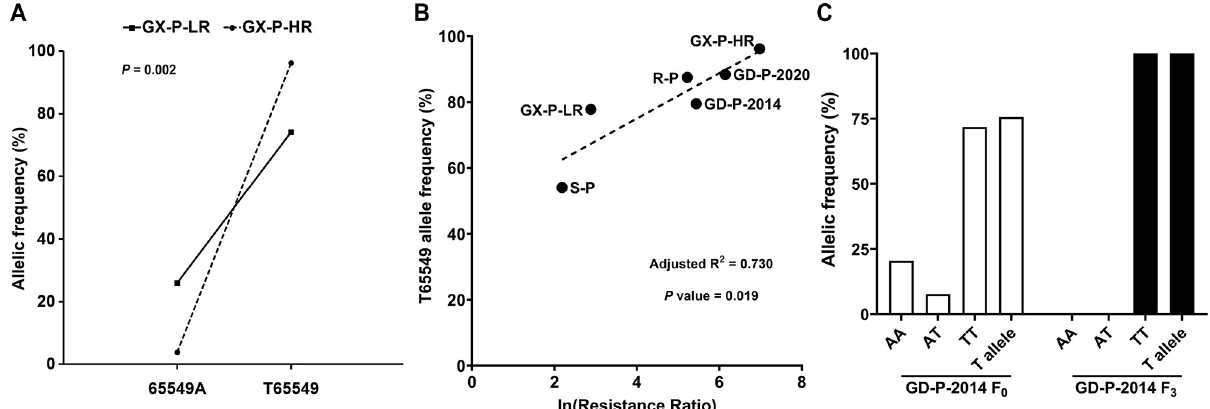
Fig 2. Correlation among NlPrx T65549 allele frequency, resistance level, and imidacloprid selection. (A) Significant correlation ( P = 0.002) between the NlPrx T65549 allele and imidacloprid resistance in GX-P-LR and GX-P-HR. (B) Correlation between the NlPrx T65549 allele frequencies and the Ln-transformation of resistance ratios of 6 N . lugens populations/subpopulations. (C) Changes in the frequencies of the genotypes of the NlPrx 65549 SNP site and of the T65549 allele of GD-P-2014 before (F 0 ) and after laboratory selection for 3 generations (F 3 ) with 60 mg/l imidacloprid. Numerical values are provided in S1 Data (doi: 10.6084/m9.figshare.14177009).